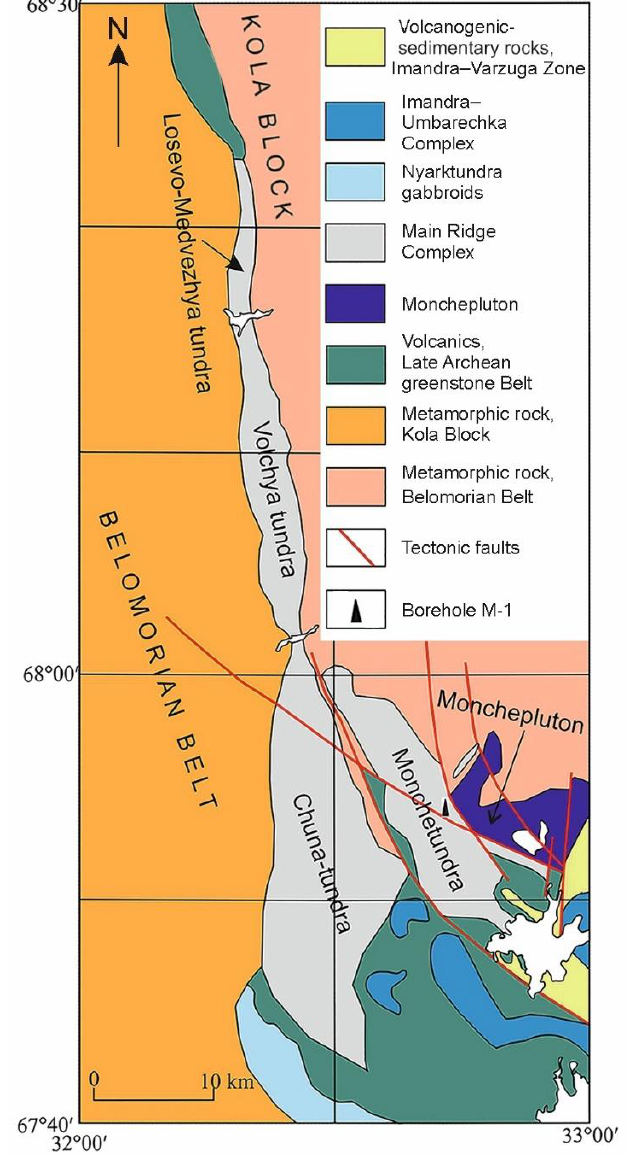
Figure 4. Location map of gabbro-anorthosites of the Main Ridge Complex, modified after [12]. The massifs were formed within the same period: the Monchetundra—2505–2470 Ma; Chunatundra—2467 ± 7 Ma; and Volchetundra—2473–2463 Ma [6,12,14,25]. The